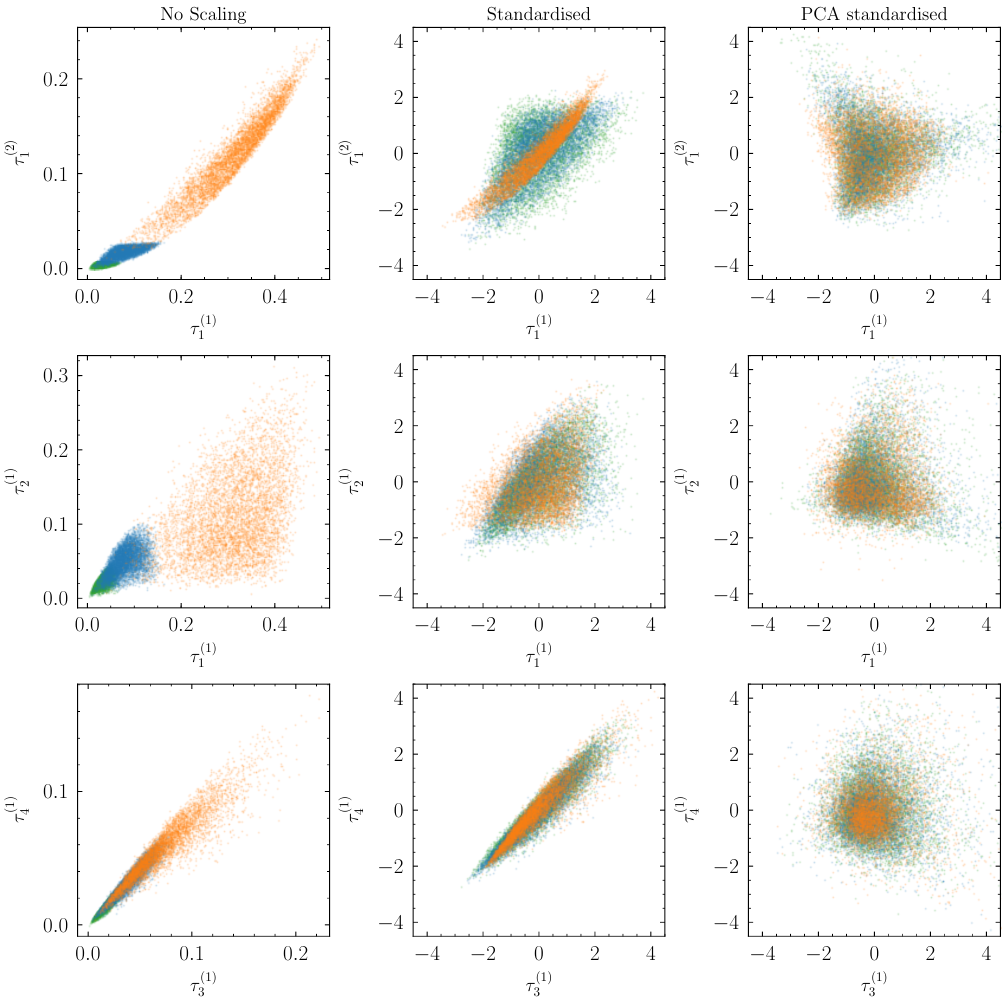
Figure 5 . N-subjettiness variables for QCD, plotted in three mass windows and with three di(cid:11)erent levels of processing. Green: 35 GeV < m J < 40 GeV, blue: 80 GeV < m J < 85 GeV, orange: 265 GeV < m J < 275 GeV. Left column: bare (cid:28) variables. Middle column: standardised (cid:28) variables, as described in section 3. Right column: standardised also along principal component axes. Each row is a di(cid:11)erent pair of (cid:28)